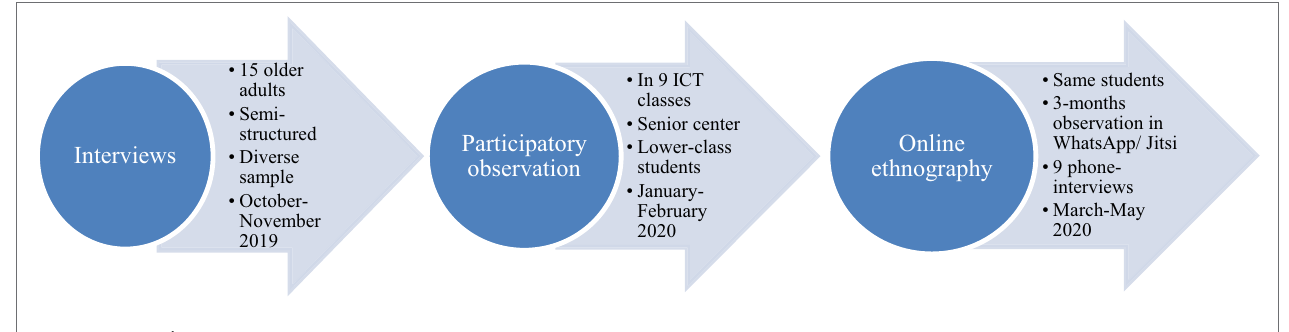
FLOW CHART 1 | The methodology in a nutshell.